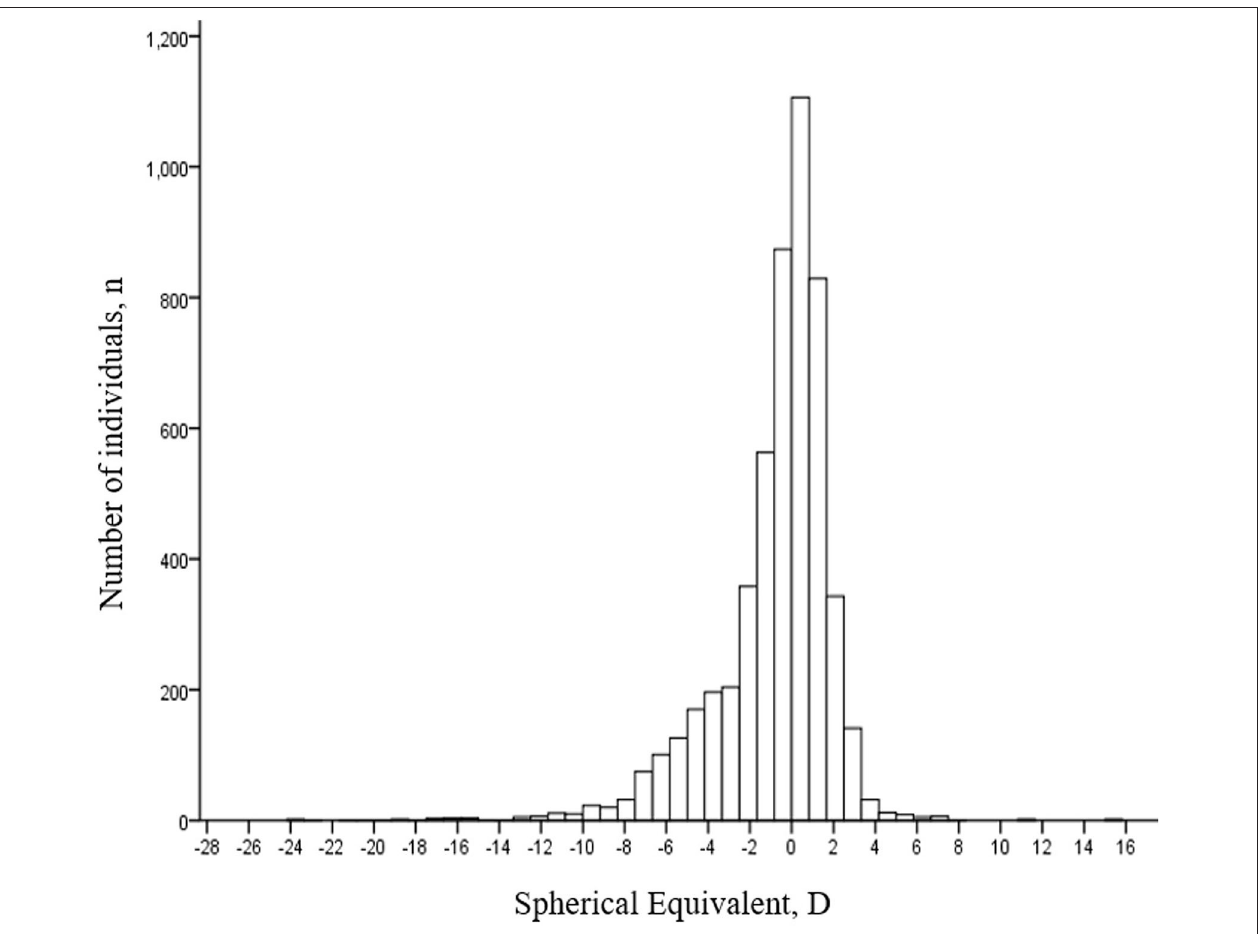
FIGURE 1 | Distribution of refractive error [diopters (D)] among the